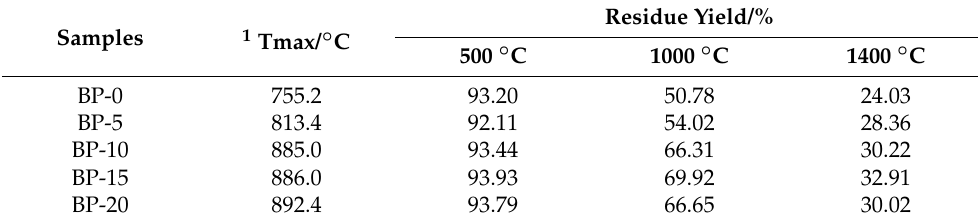
Figure 3. TG curve ( a ) and DTG curve ( b ) of MoSi 2 particles modified boron phenolic resin composites with different contents of B 4 C particles in air atmosphere. Table 2. Thermal decomposition characteristics of